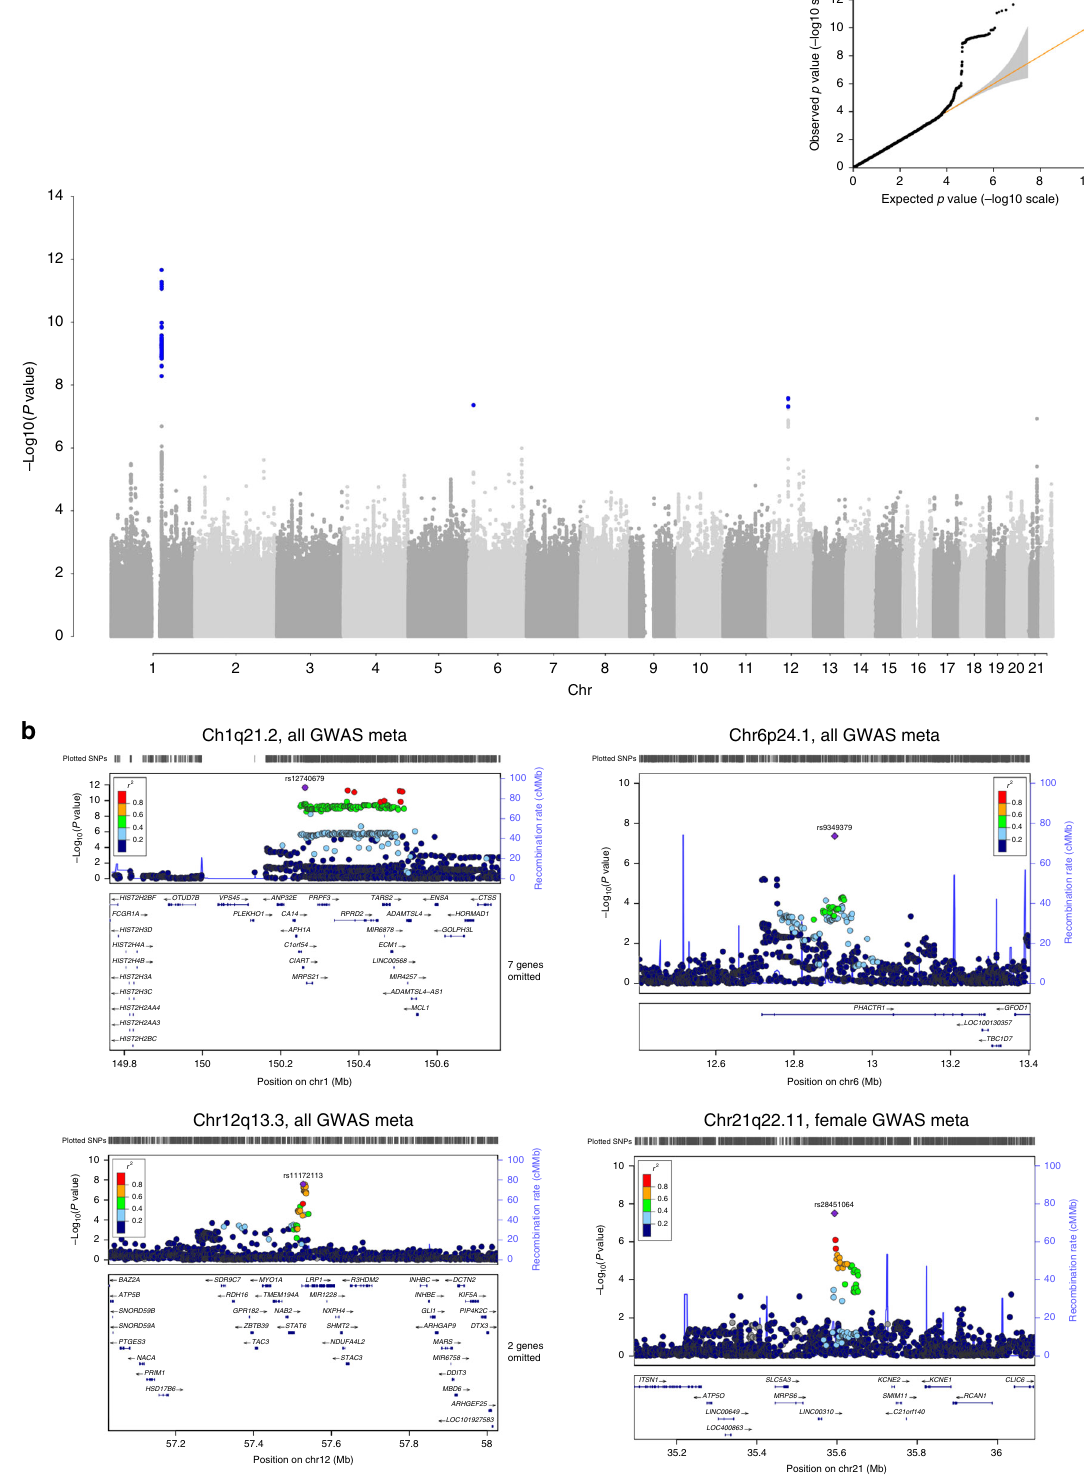
hazard ratio (HR) = 0.91 per 1 SD unit increase, 95% CI [0.89 – 0.93], P = 1.57 × 10 − 13 ) and women (adjusted HR = 0.91 per 1 SD unit increase, 95% CI [0.87 – 0.95], P = 9.46 × 10 − 6 ) (Fig. 4, Supplementary Table 7), with a 3.72-fold higher MI event rate in men ( N = 11,751/171,082) as compared to women ( N = 3725/201,974). There was no signi fi cant sex interaction with